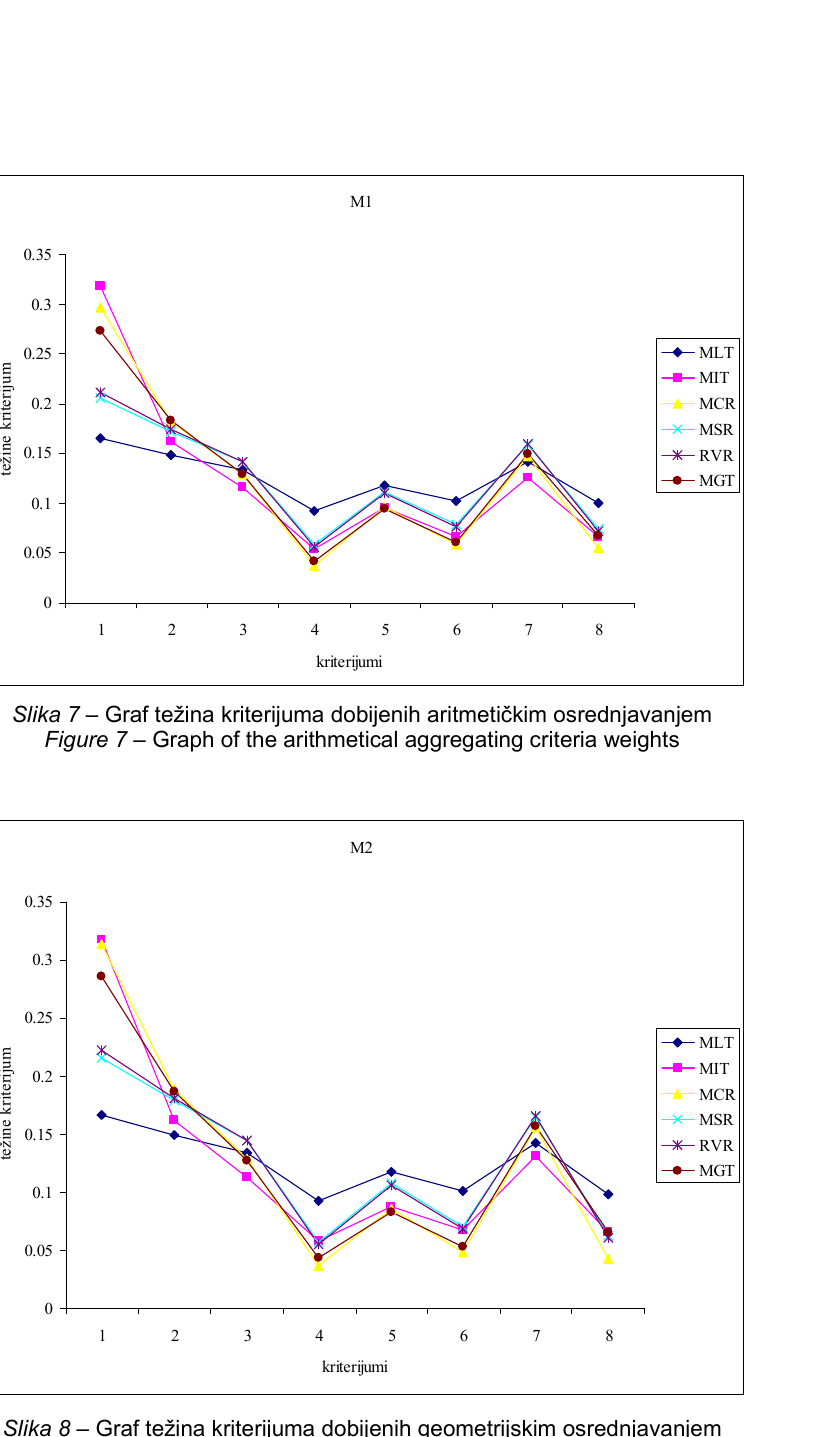
Figure 8 – Graph of the geometrical aggregating criteria